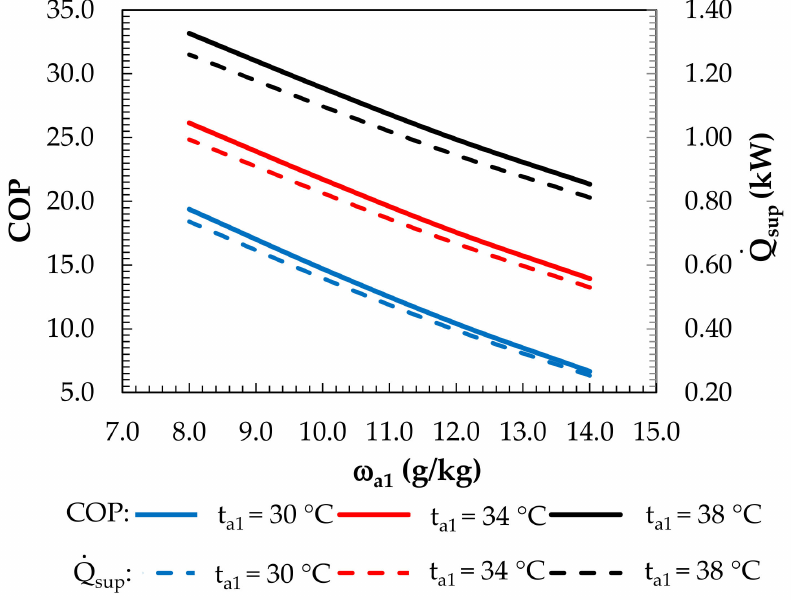
Figure 17. Effect of the inlet air humidity ratio for constant inlet air temperatures on the COP coefficient and supply cooling